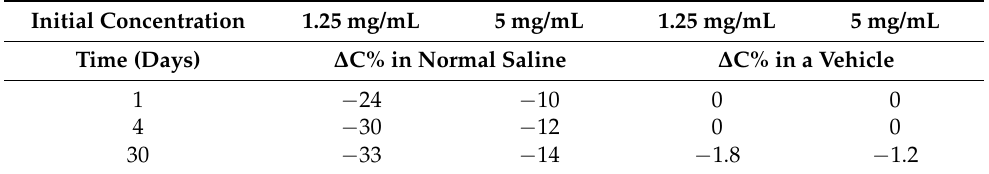
Table 1. Decrease percentage of monomeric bevacizumab (BVZ) concentration ( ∆ C%) in normal saline and in a vehicle (an aqueous solution with the same composition of the commercial product). Initial Concentration 1.25 mg/mL 5 mg/mL 1.25 mg/mL 5 mg/mL Time (Days) ∆ C% in Normal Saline ∆ C% in a Vehicle 1 − 24 − 10 0 0 4 − 30 − 12 0 0 30 − 33 − 14 − 1.8 −